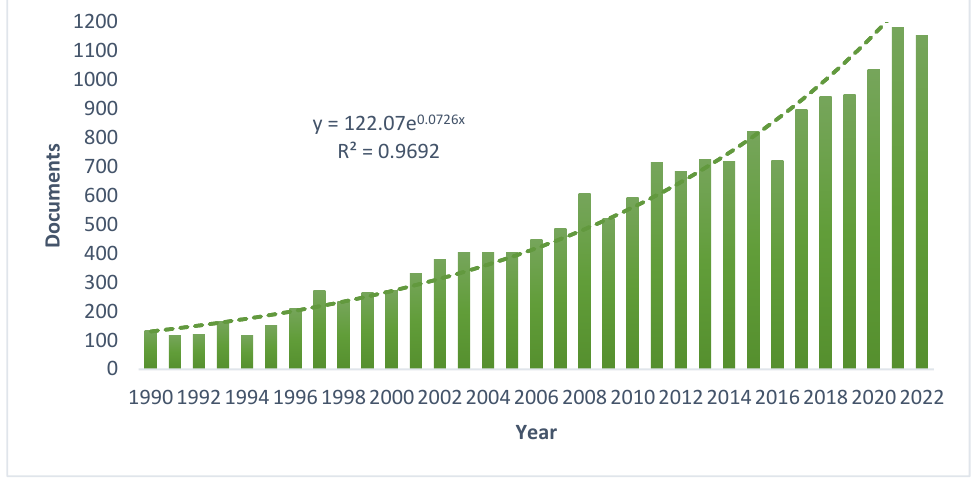
Figure 1 . Evolution of the number of publications per year (from 1990 to 2022) reporting on algae as